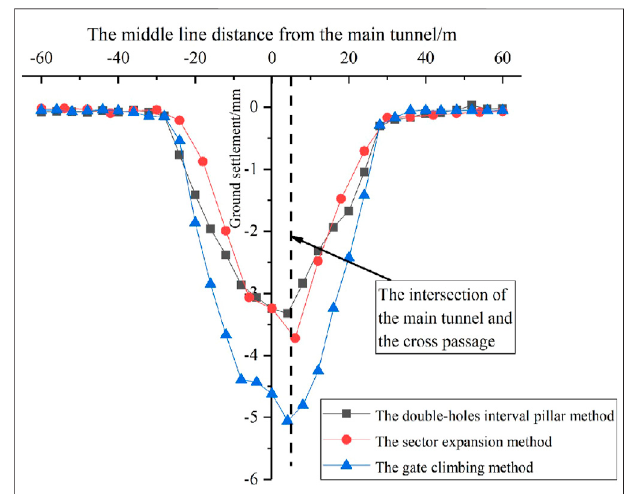
FIGURE 7 | The comparison of the ground